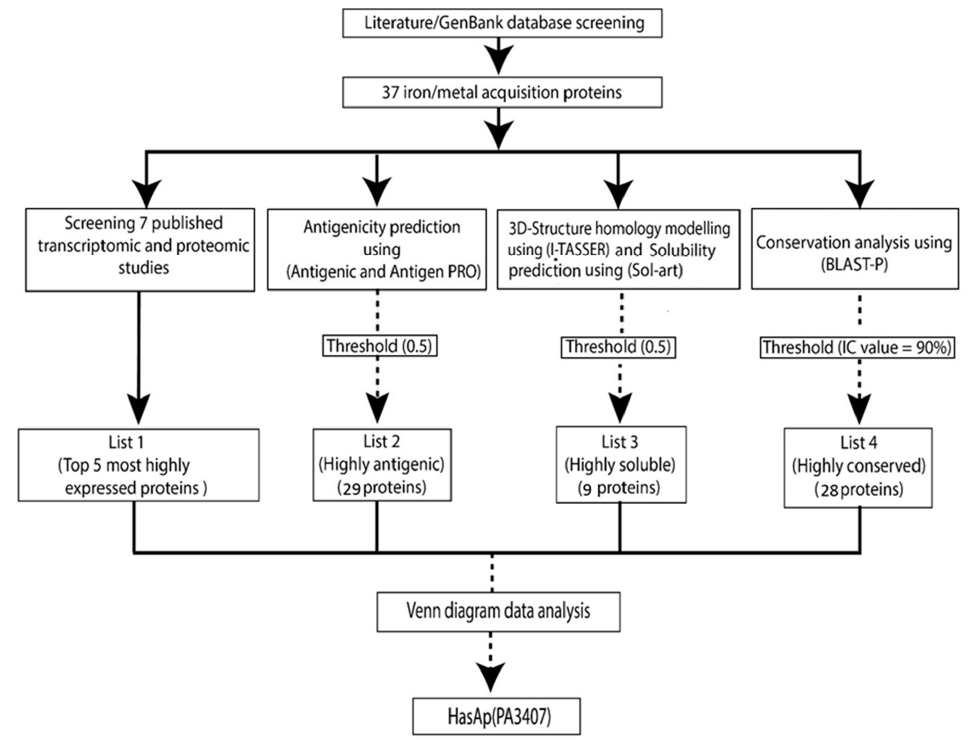
Figure 2. Flow chart describing the in silico selection of the candidate antigen.